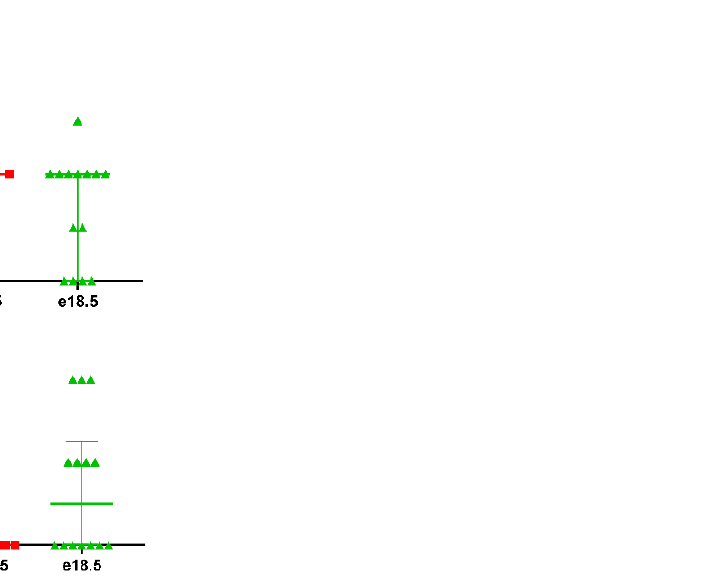
Figure 4. Transcriptional expression of hepatic inflammatory markers in BPH/5 mice preconception and at mid-late gestation ( n = 7–15 per group). ( A ) Pan interferon (IFN) mRNA expression was sig- nificantly downregulated at e18.5, ( B ) Interleukin 1-beta (IL-1 β ) was unchanged during gestation, ( C ) Tumor necrosis factor-alpha (TNF α ) expression was upregulated at e12.5, ( D ) C-X-C motif chemokine ligand-1 (CXCL-1) was unchanged during gestation, ( E ) C-X-C motif chemokine ligand- 2 (CXCL-2) mRNA expression was significantly downregulated at e18.5, ( F ) C-X-C motif chemokine ligand-10 (CXCL-10) mRNA expression was significantly upregulated at e12.5, ( G ) Toll-like recep- tor-2 (TLR-2) transcription was significantly upregulated at e12.5, ( H ) Toll-like receptor-4 (TLR-4) expression was significantly downregulated at e18.5. * p < 0.05, ** p < 0.01, **** p < 0.0001 ns, not significant.